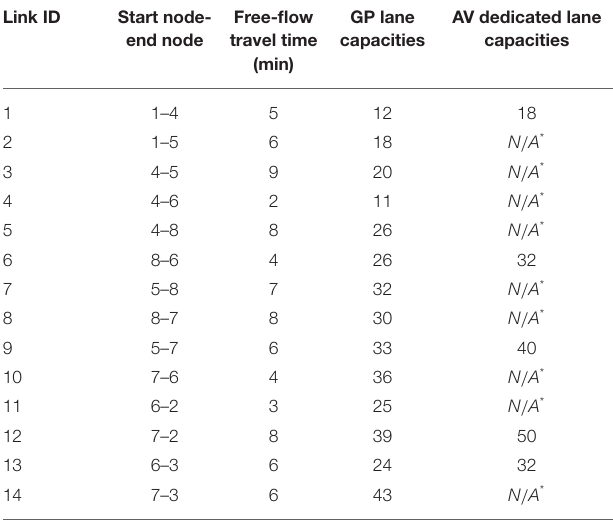
TABLE 1 | Link characteristics for the eight-node